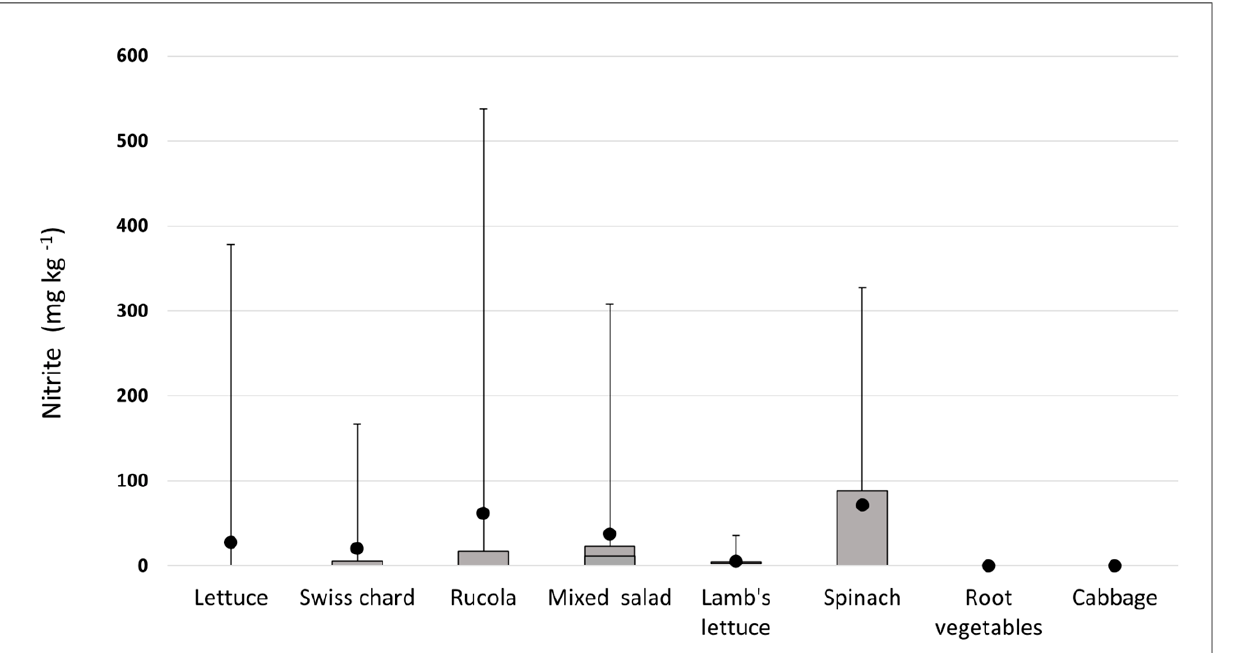
Table 3. Prevalence of the nitrite concentrations with accompanying nitrate concentrations in these